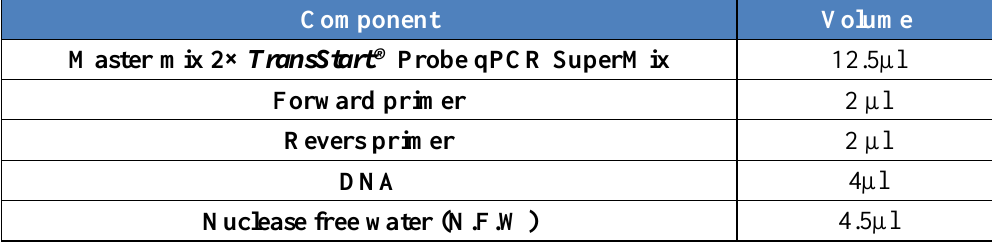
Table 2: Reaction Component and volume for RT PCR used in IL-8 gene SNP